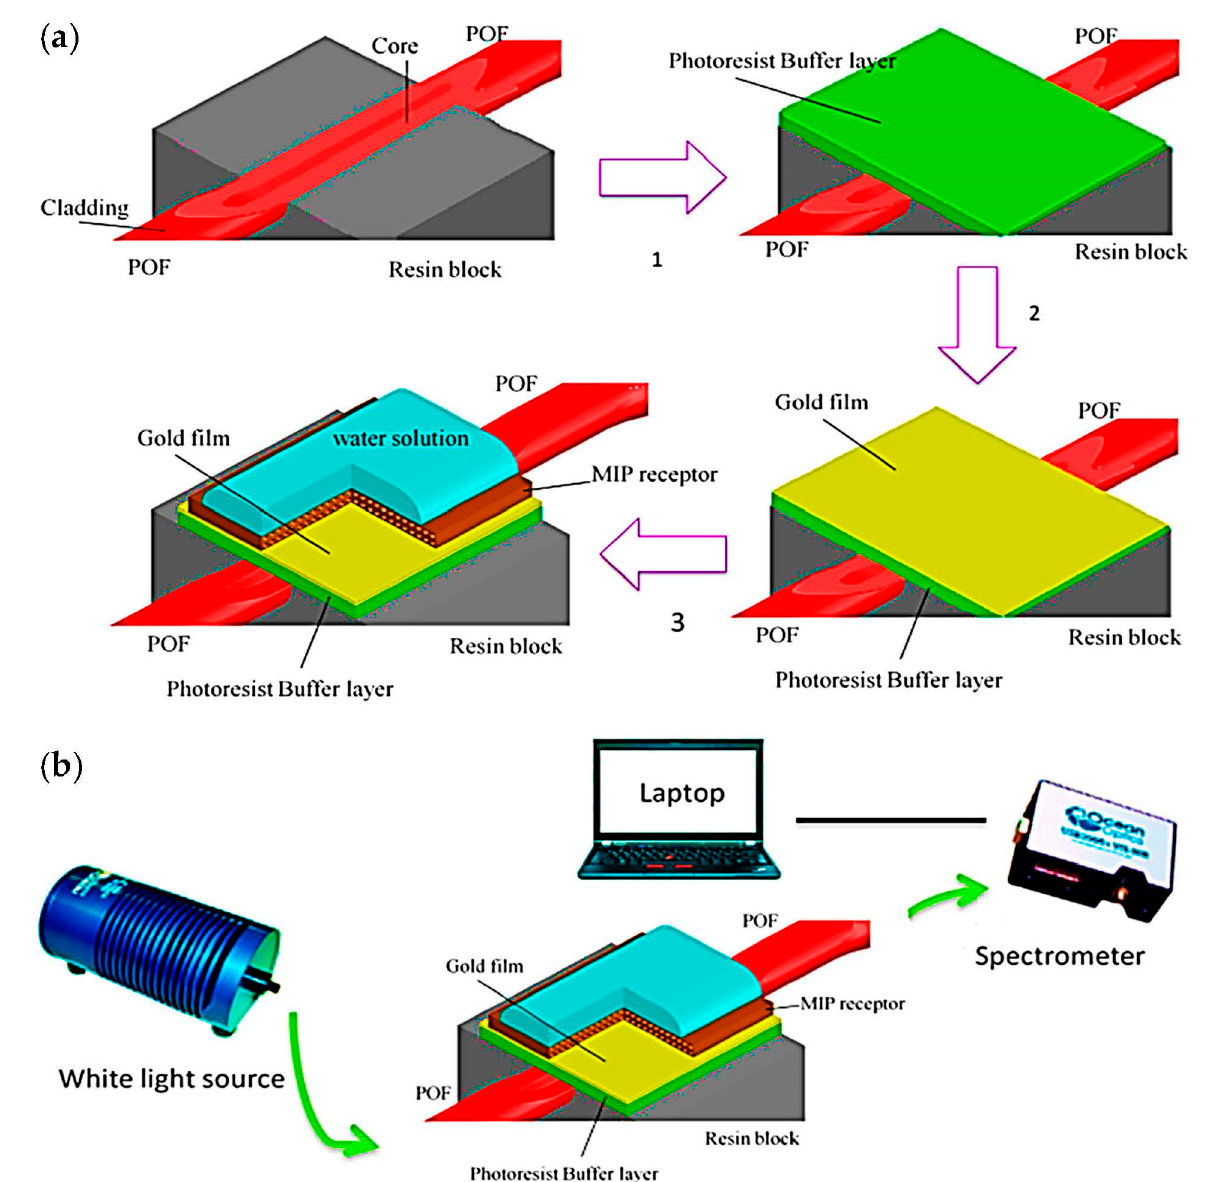
Figure 3. ( a ) Steps to realize a MIP ‐ based SPR sensor in a D ‐ shaped POF; ( b ) outline of the experi